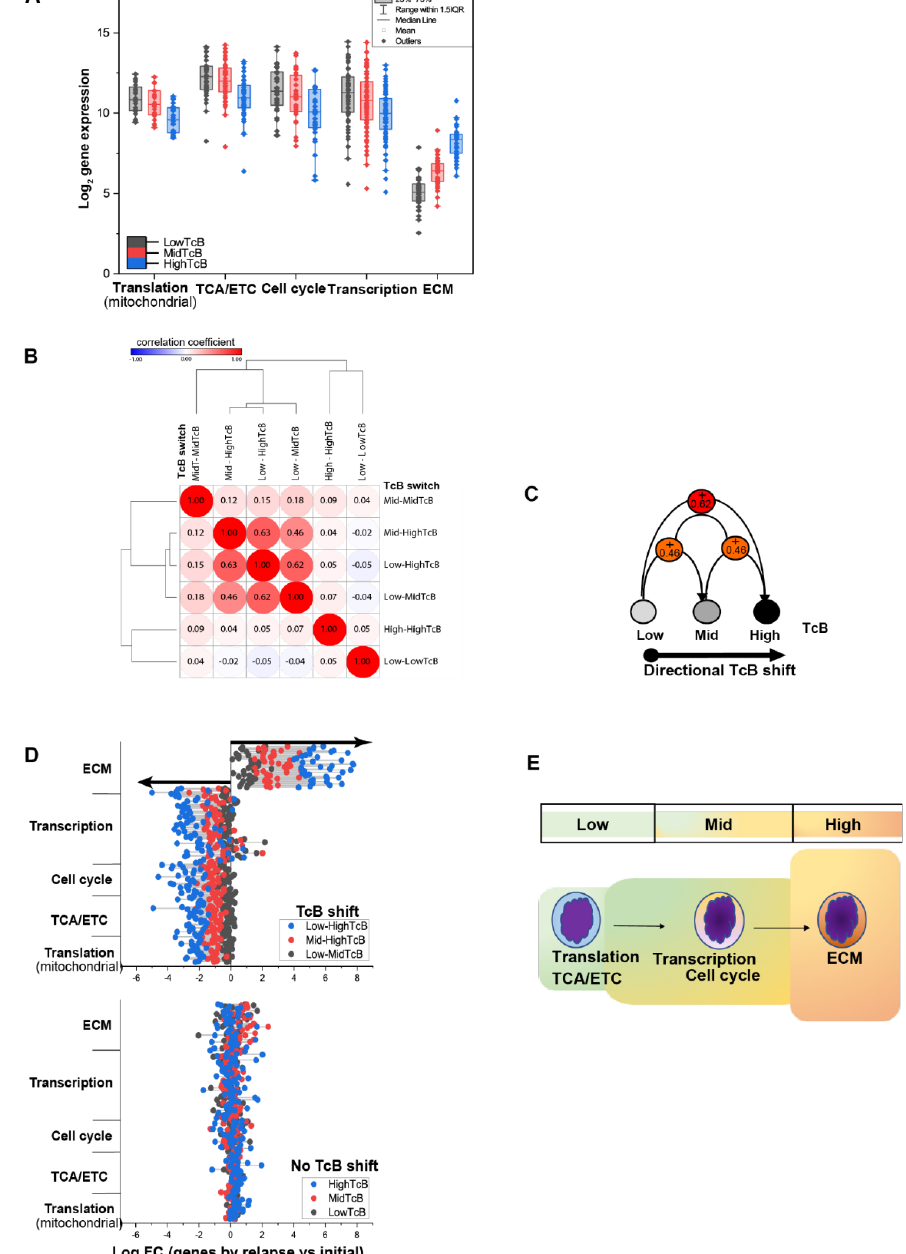
Figure 5. Biological trajectory of cancer progression in pediatric ALL. ( A ) The box plot represents log 2 expression values (y-axis) of genes representing higher-order biological processes (x-axis) en- riched by TcB groups. ( B , C ) Correlation graph by Spearman rank showing r values of TcB values comparing leukemic relapse with and without TcB shifts indicates a positive correlation in the order of increasing TcB shifts. ( D ) Lollipop plot comparing log 2 fold changes in gene expression (in x-axis) associated with higher-order processes (y-axis) between relapse and the initial diagnosis is shown with and without TcB shift. ( E ) Schematics illustrating the predicted biological progression path in